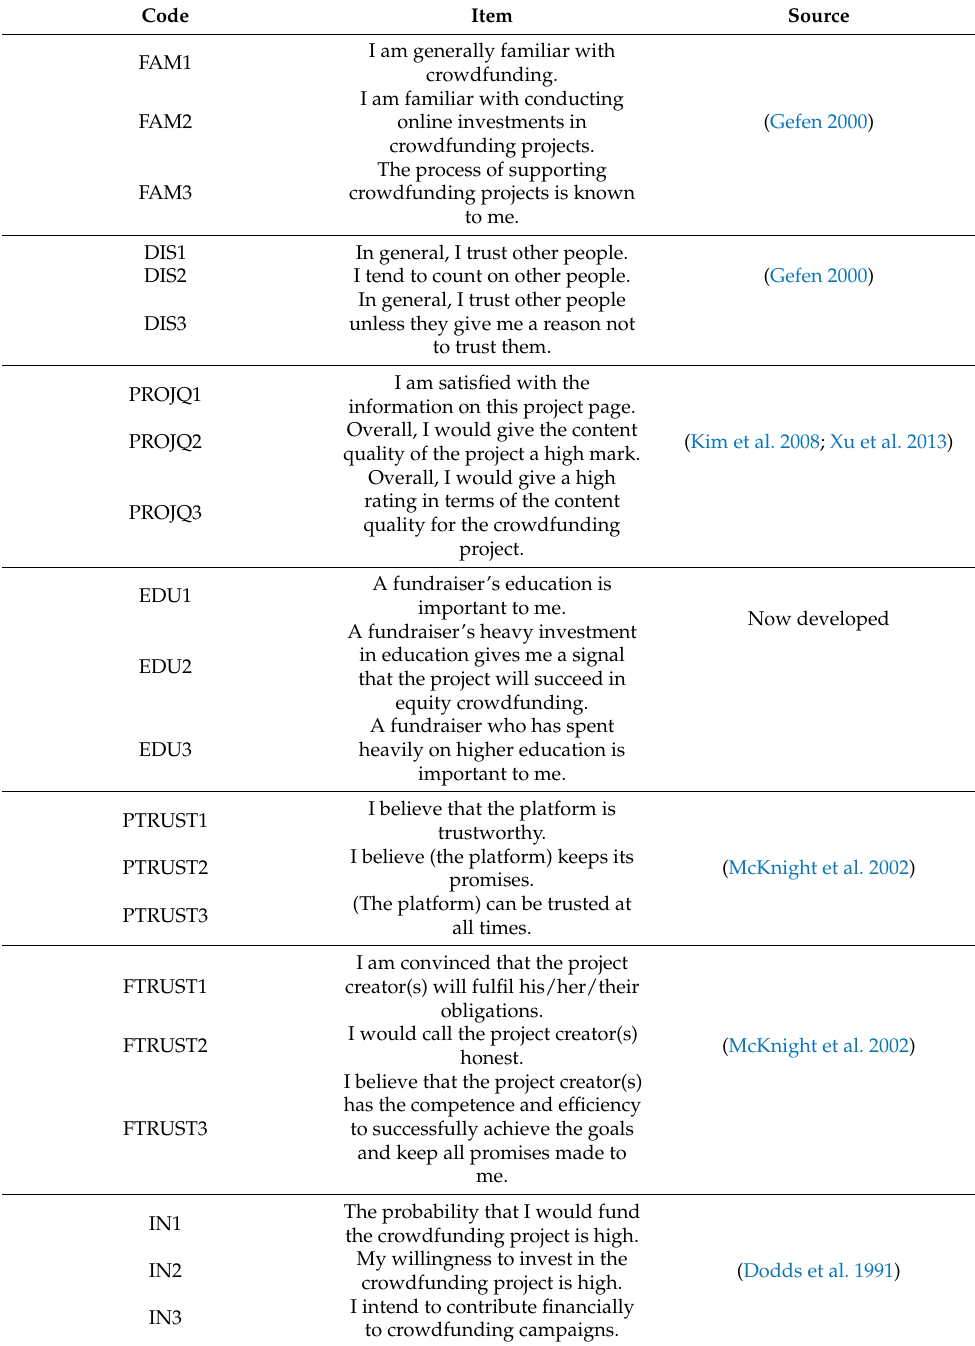
Table 2. Survey items, database codes and reference